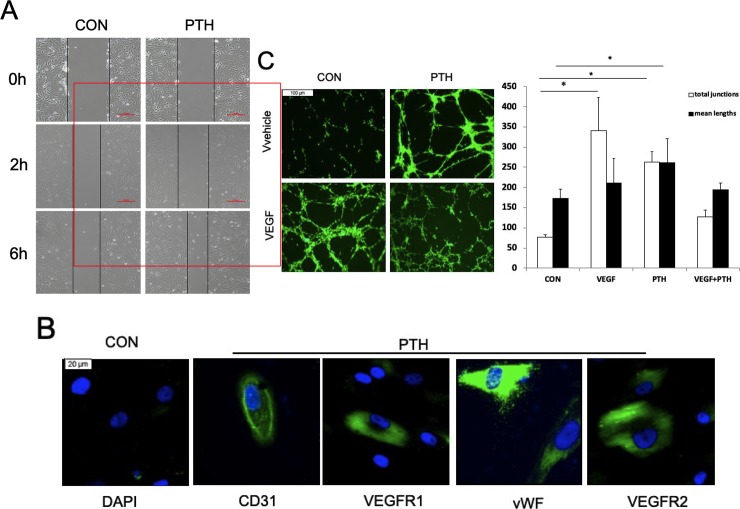
PTH promotes MSC migration and angiogenic differentiation in vitro.(A) Results from the scratch wound healing assay of MSCs after PTH treatment at different time points in vitro. (B) Immunofluorescence detection of vWF, CD31, VEGF1 and VEGFR2 expression in MSCs after 7 days of PTH treatment compared to that observed for the controls. (C) Tube-like network formation and quantitative analyses of the MSCs were examined after 20 h of PTH treatment. Representative micrographs obtained at 10× (A), 40× (B, scale bar, 10 μm) and 10× (C). Student’s t test for two groups comparisons was performed; *P < 0.05.